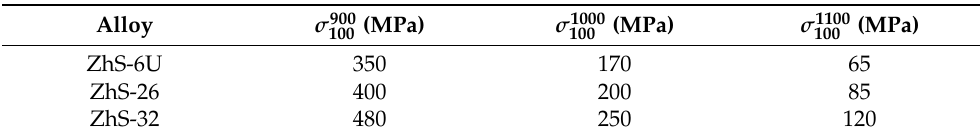
Table 1. Creep resistance of super ZhS alloys